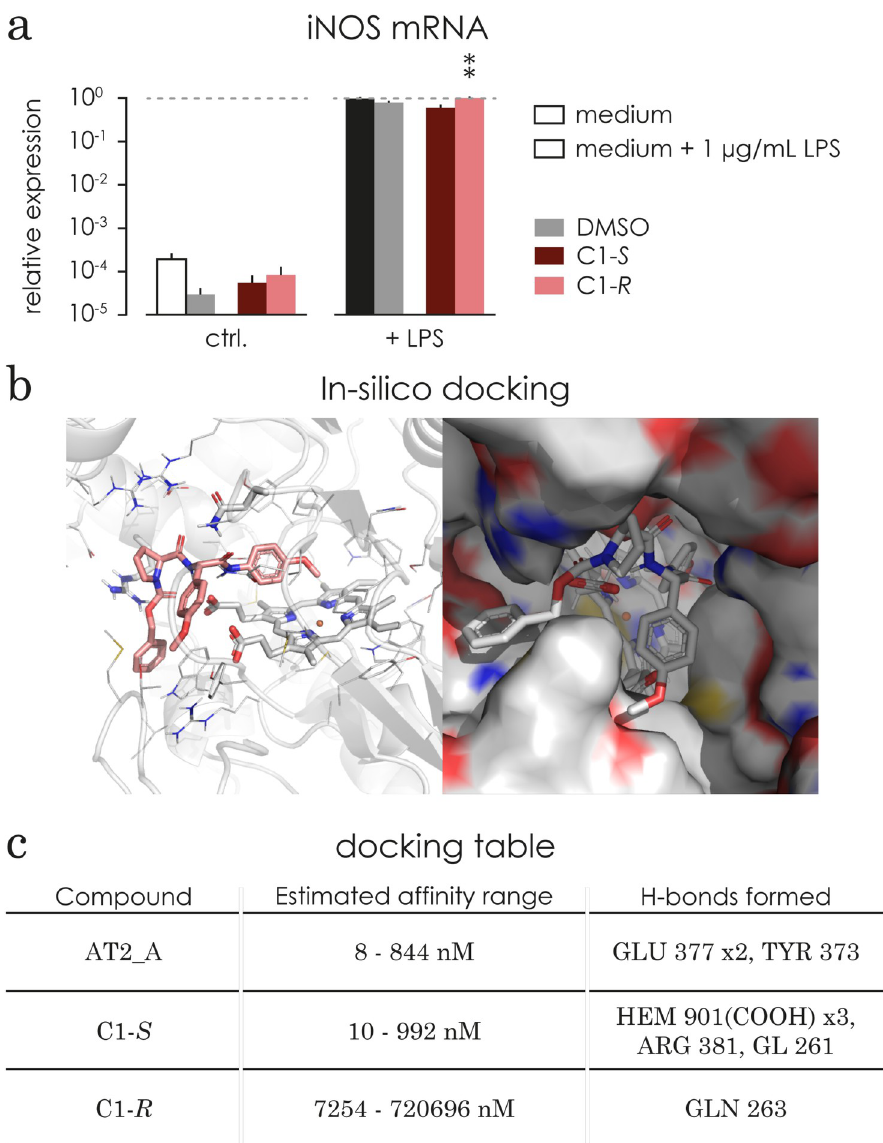
Fig 7. C1 does not change iNOS mRNA levels and C1- S has a higher affinity than C1- R in an in-silico docking calculation. a) The relative expression of iNOS mRNA was evaluated under basal conditions and LPS stimulated (1 hour compound treatment + additional 24 hours 1 μ g/mL LPS) conditions. Under basal conditions iNOS mRNA level was barely detected. DMSO, C1, C1- S and C1- R had no significant effect on the basal expression of iNOS mRNA. Upon 1 μ g/mL LPS stimulation iNOS mRNA expression increased more than 5000 fold independently of the treatment (induced vs basal: p < 0.0001). Within the stimulated conditions, treatment with DMSO, C1, C1- S and C1- R did not significantly alter iNOS expression. All treatments led to a significant increase in iNOS mRNA upon LPS stimulation C1: p < 0.0001, C1- S : p = 0.0236, C1- R : p < 0.0001, DMSO: p < 0.0001). ��� p < 0.001 comparing to plain medium control (non-matching 2way ANOVA followed by Sidak test). b) Predicted binding mode of compounds C1- S in the binding pocket of iNOS structure (PDB 3e7g). Protein binding site shown in cartoon representation (colour coding by element oxygen = red, nitrogen = blue, sulphur = yellow, carbon = grey). Heme as well as two hydrogen bond forming residues shown as sticks. Compound C1- S represented as sticks in salmon. Right: Surface representation shown from a different angle. Figure generated using PyMol [40]. c) Estimated affinity ranges (using SeeSAR) for the co-crystallized ligand (AT2_A, re-docking) as well as compounds C1- S and C1- R sorted by ascending mean estimated affinity (the lower the value the better) docked into the binding site of iNOS (PDB structure 3e7g 39